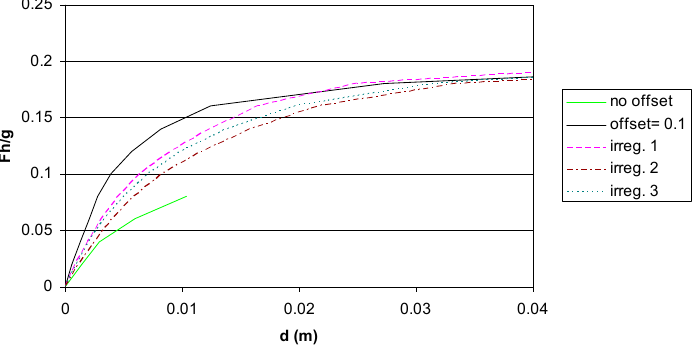
Figure 6. Failure load for wall models: regular model of rectangular blocks with cross-joint offsets of 0 and 0.1 m, and three irregular coursed patterns.